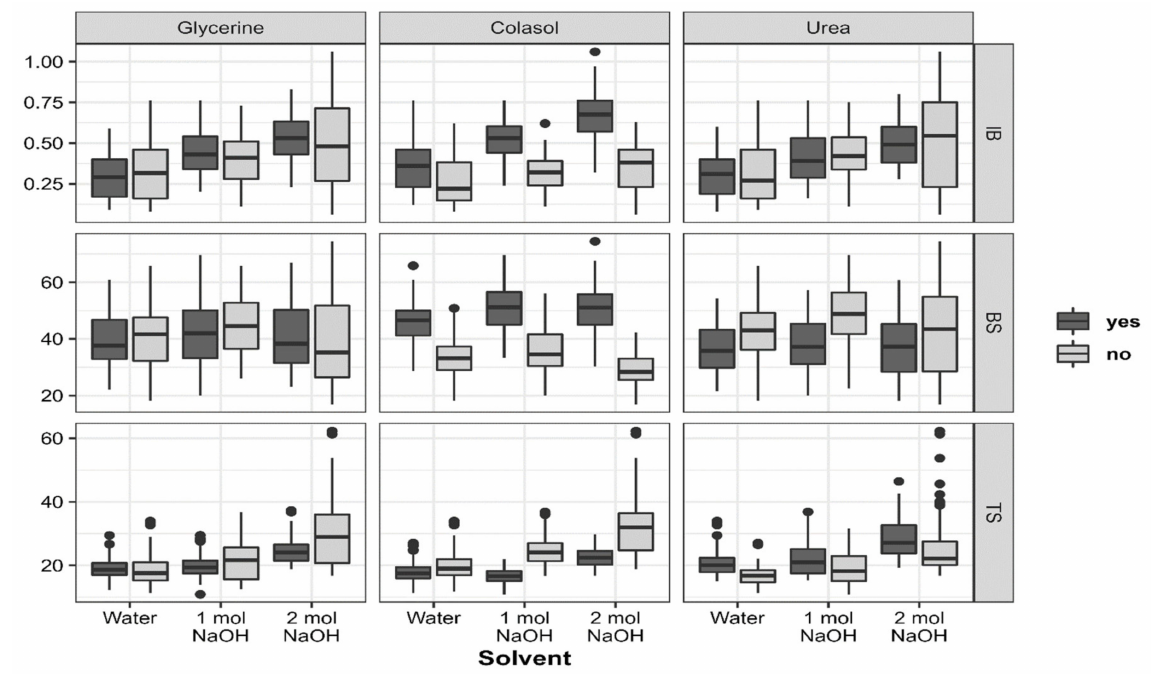
Figure 3. Effects between the solvent, glycerine, colasol and urea on the mechanical properties of the produced